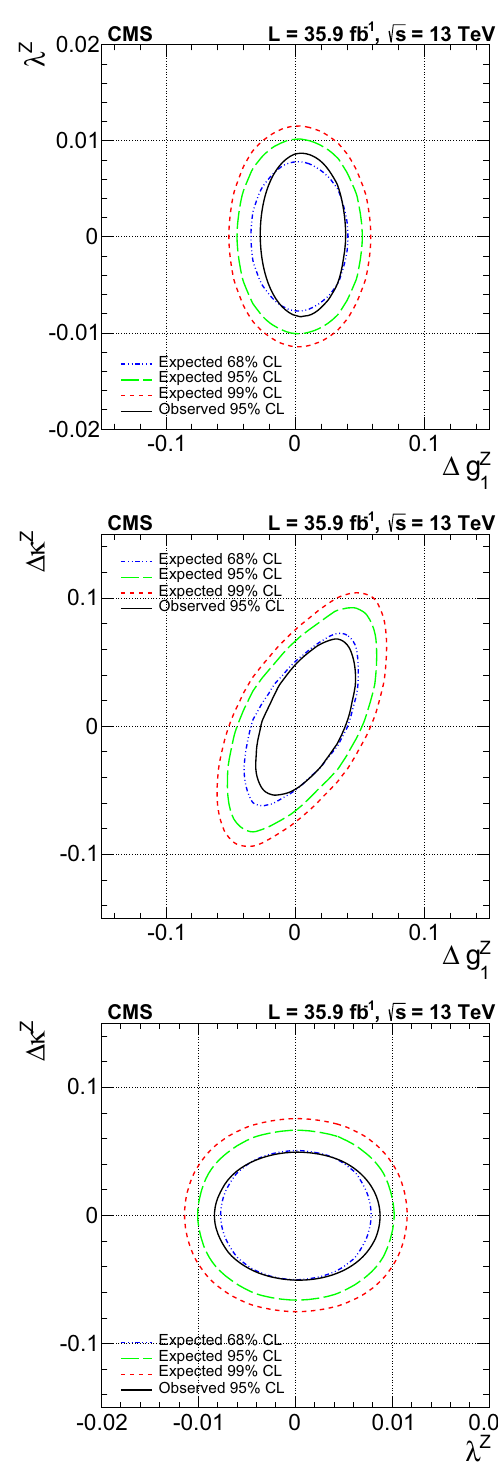
Fig. 13 Expected and observed two-dimensional limits on the EFT parameters at 95% CL from the combination of EW Wjj and EW Zjj analyses ity in signal events is expected because the final-state objects originate from EW interactions, in contrast with the radiative QCD production of jets in DY Wjj events.